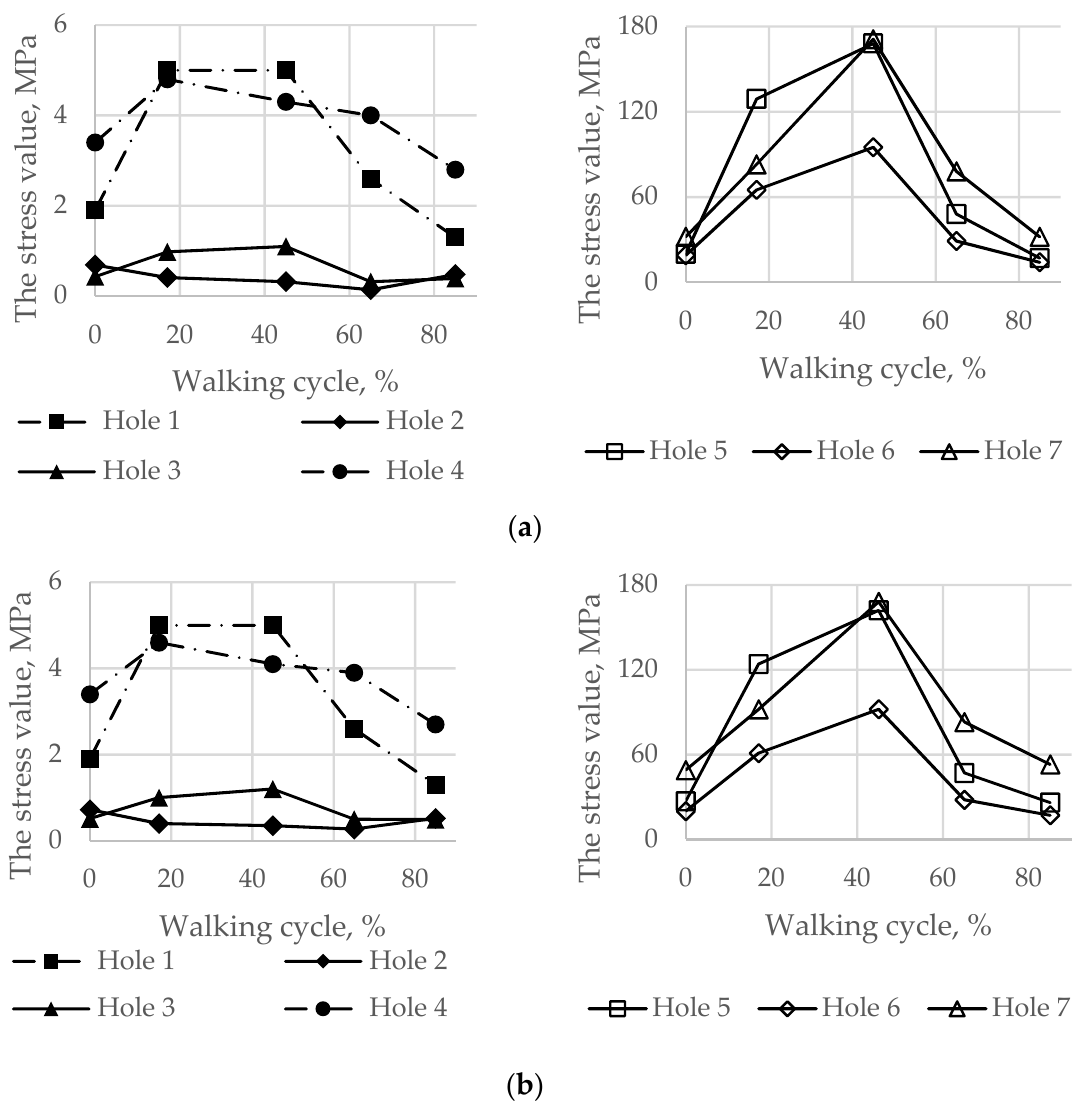
Figure 14. Maximum von Mises stress in the bone tissue on the boundaries of the holes шт in the walking cycle phases: ( a ) the pretension force equal to 500 N; ( b ) the pretension force equal to 1000 N.